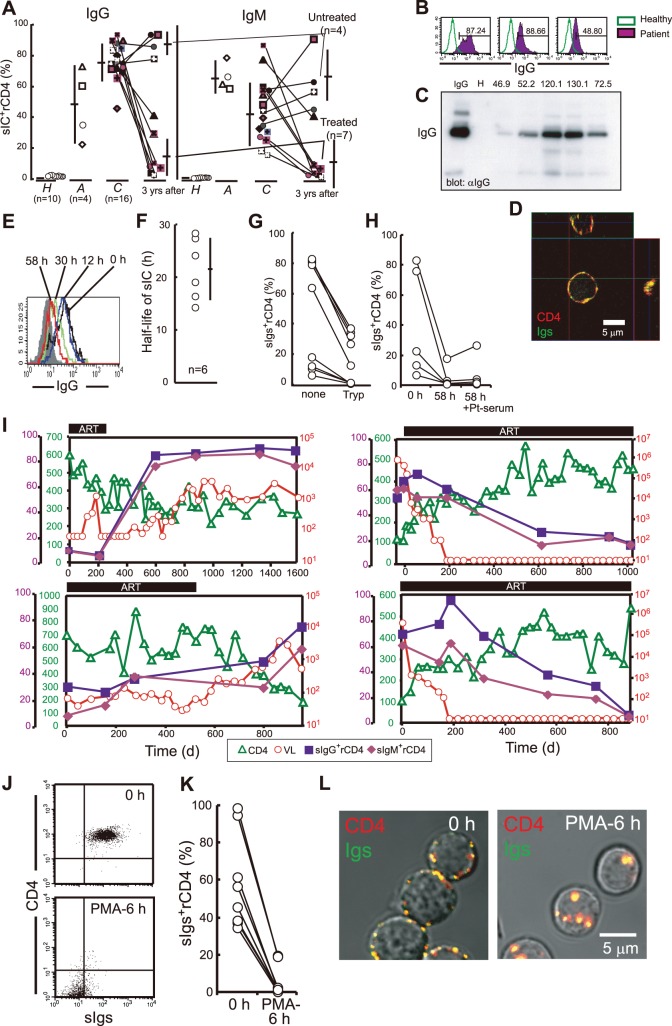
sICs of IgG or IgM on purified rCD4s from HIV-1+ Pts is molecularly linked to surface CD4 and shows slow turnover.(a) Summary of the percentages of IgG+ rCD4s or IgM+ rCD4s in healthy individuals (H), acute HIV-1+ individuals (A), and chronic pre-symptomatic HIV-1+ individuals (C) before, after 3 yrs of complete suppression of VL (<50 copies/ml) with ART (Treated), or untreated for 3 yrs (Untreated). Bars, SD. (b) Representative FACS of IgG expression on rCD4s from HIV-1+ Pts. (c) Anti-IgG Ab immunoblotting of purified HIV-1+ Pt rCD4 lysates. For the comparison of IgG binding levels, MFI values of IgG on rCD4s of the lysate samples are denoted above. IgG, positive IgG control; H, rCD4 lysate from an HIV-1-seronegative healthy donor. (d) Three-dimensional reconstitution confocal micrographs of Igs (Qdot655, green) and CD4 (Cy2, red) in rCD4s from an HIV-1+ Pt. (e, f) Representative time course of FACS (e) and calculated half-life of sICs (f) in purified rCD4s from an HIV-1+ Pt. Bar, SD. (g) Percentage of Ig+ cells in purified HIV-1+ Pt rCD4s without (none) or with 10 min of 0.05% trypsinization (Tryp). (h) Percentage of Ig+ cells in purified HIV-1+ Pt rCD4s before (0 h), after 58 h of culture (58 h), or 58 h of culture with exposure to HIV-1+ Pt serum (58 h+Pt-serum). (i) Changes in percentages of IgM+ or IgG+ rCD4s in blood, plasma VL, and CD4 lymphocyte counts during ART in the four HIV-1+ Pts. Two patients discontinued therapy after substantial suppression of VLs (left panels). HIV-1 RNA levels in two other patients were suppressed to undetectable levels for approximately 2 yr with ART (right panels). (j, k) Summary of the percentages (k) and representative FACS (j) of Igs on purified HIV-1+ Pt rCD4s before and after 6 h of PMA (0.3 ng/ml) exposure. (l) Fluorescence and DIC images of purified HIV-1+ Pt rCD4s that were stained with anti-Ig Abs (Cy2, green) and goat polyclonal anti-CD4 (Cy3, red) before and after 6 h of PMA exposure. Data in d and l are representative of five independent experiments.